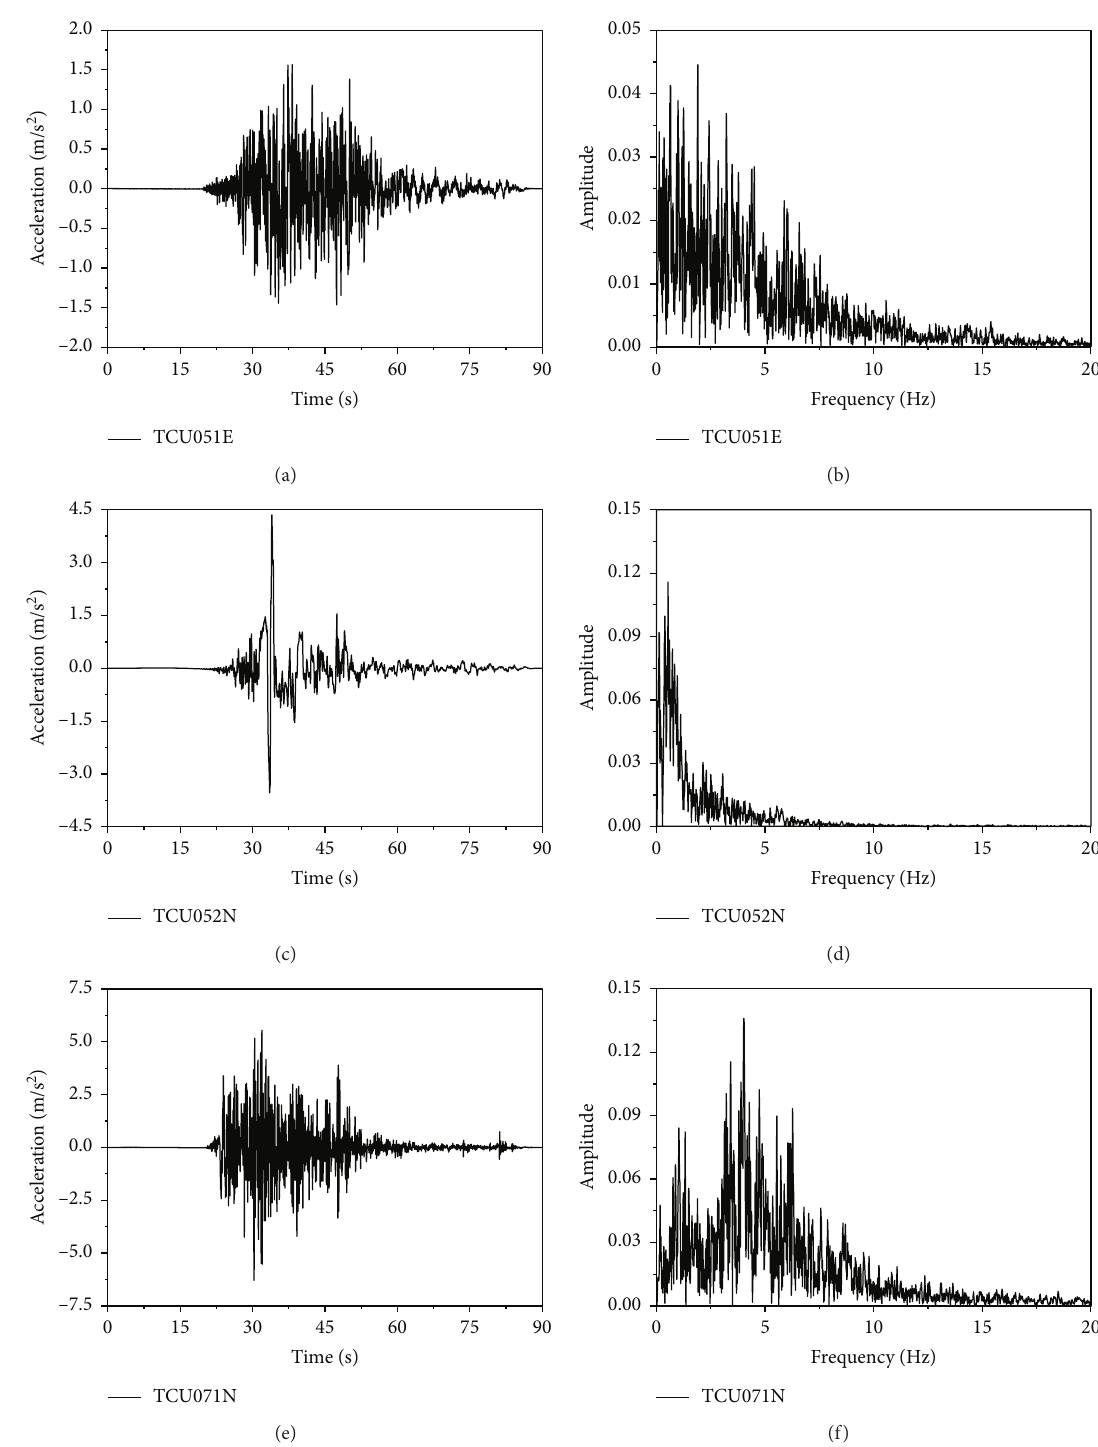
Figure 10: (a) The acceleration time-history of forward-directivity ground motion; (b) the corresponding Fourier spectra of forward- directivity ground motion; (c) the acceleration time-history of fling-step ground motion; (d) the corresponding Fourier spectra of fling-step ground motion; (e) the acceleration time-history of nonspeed ground motion; (f) the corresponding Fourier spectra of nonspeed ground